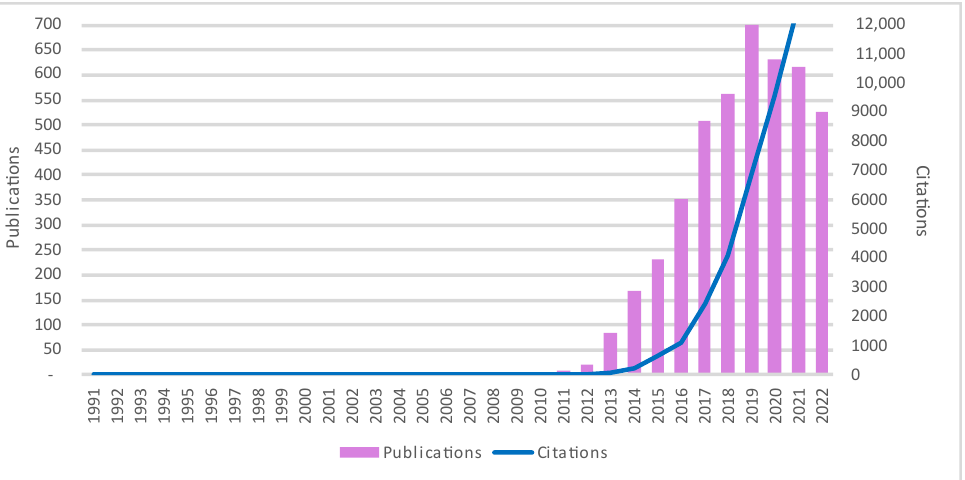
Figure 1. An overview of publications and citations on the topic of Smart cities. Source: own analysis as per Web of Science (2022).